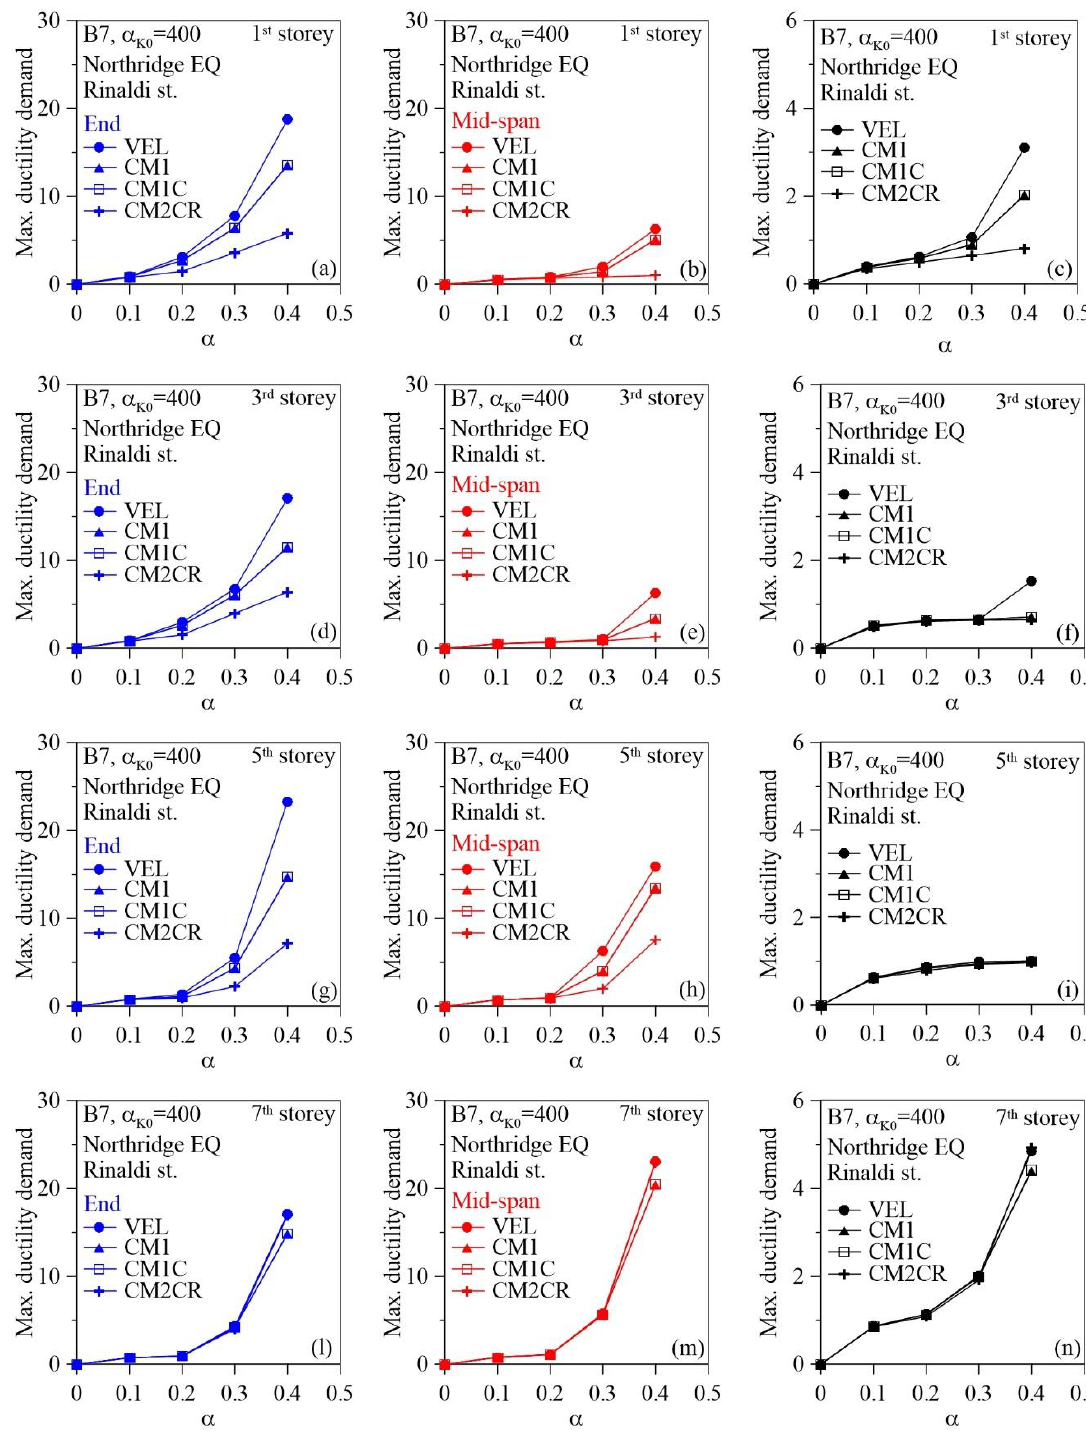
Figure 7. Ductility demands of the B7 structure subjected to the Northridge EQ: end sections ( a , d , g , l ) and mid-span sections ( b , e , h , m ) of beams; end sections ( c , f , i , n ) of columns.